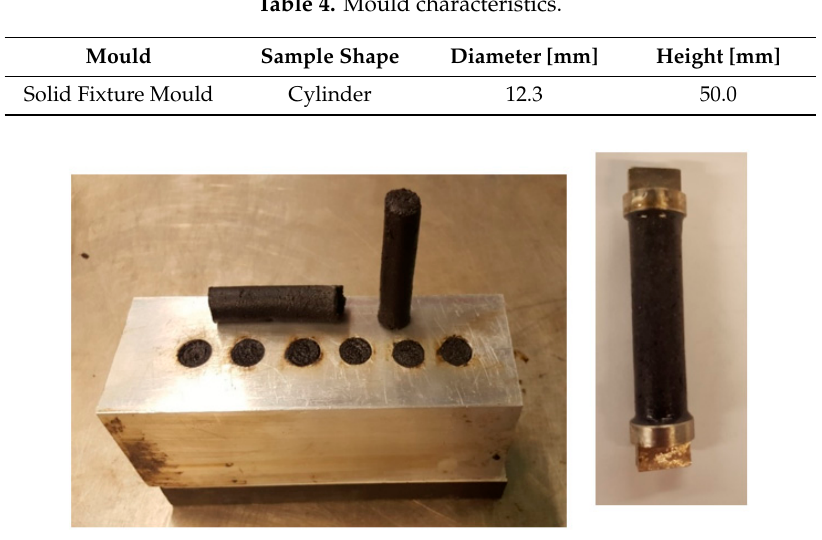
Figure 1. Steel mould and extracted mortar sample.